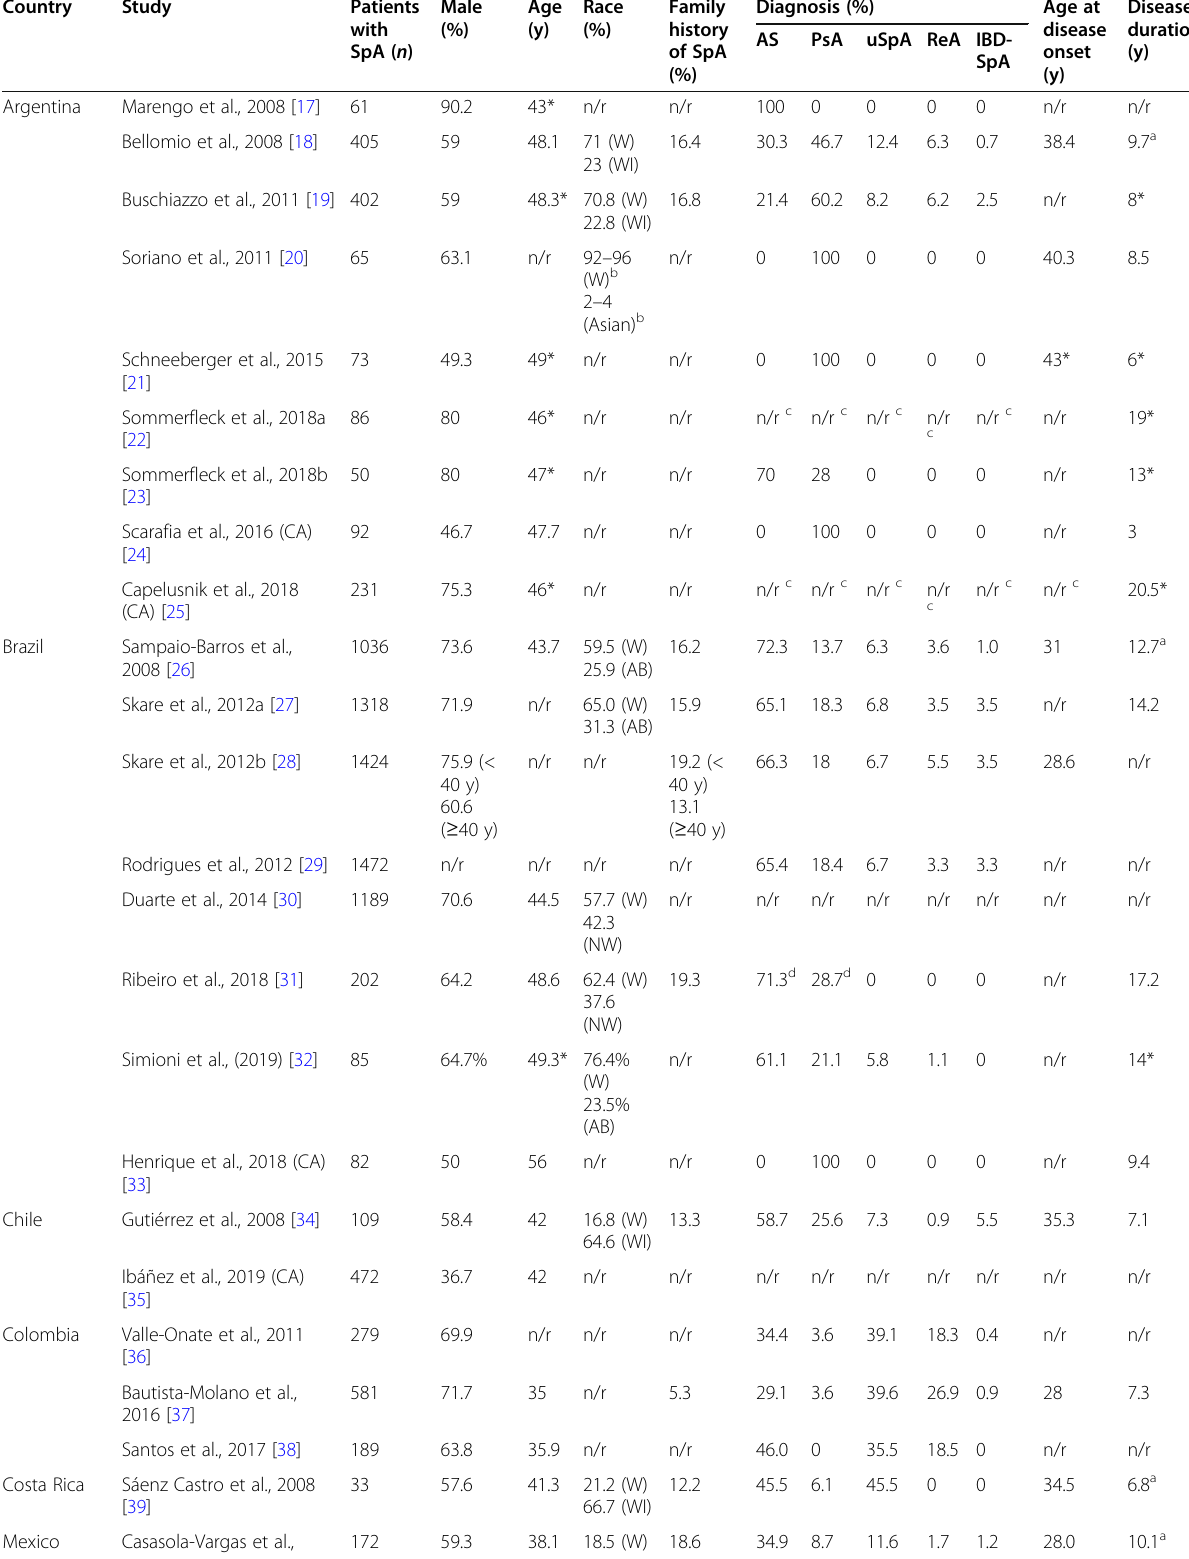
Table 2 Demographics of patients with SpA across Latin America